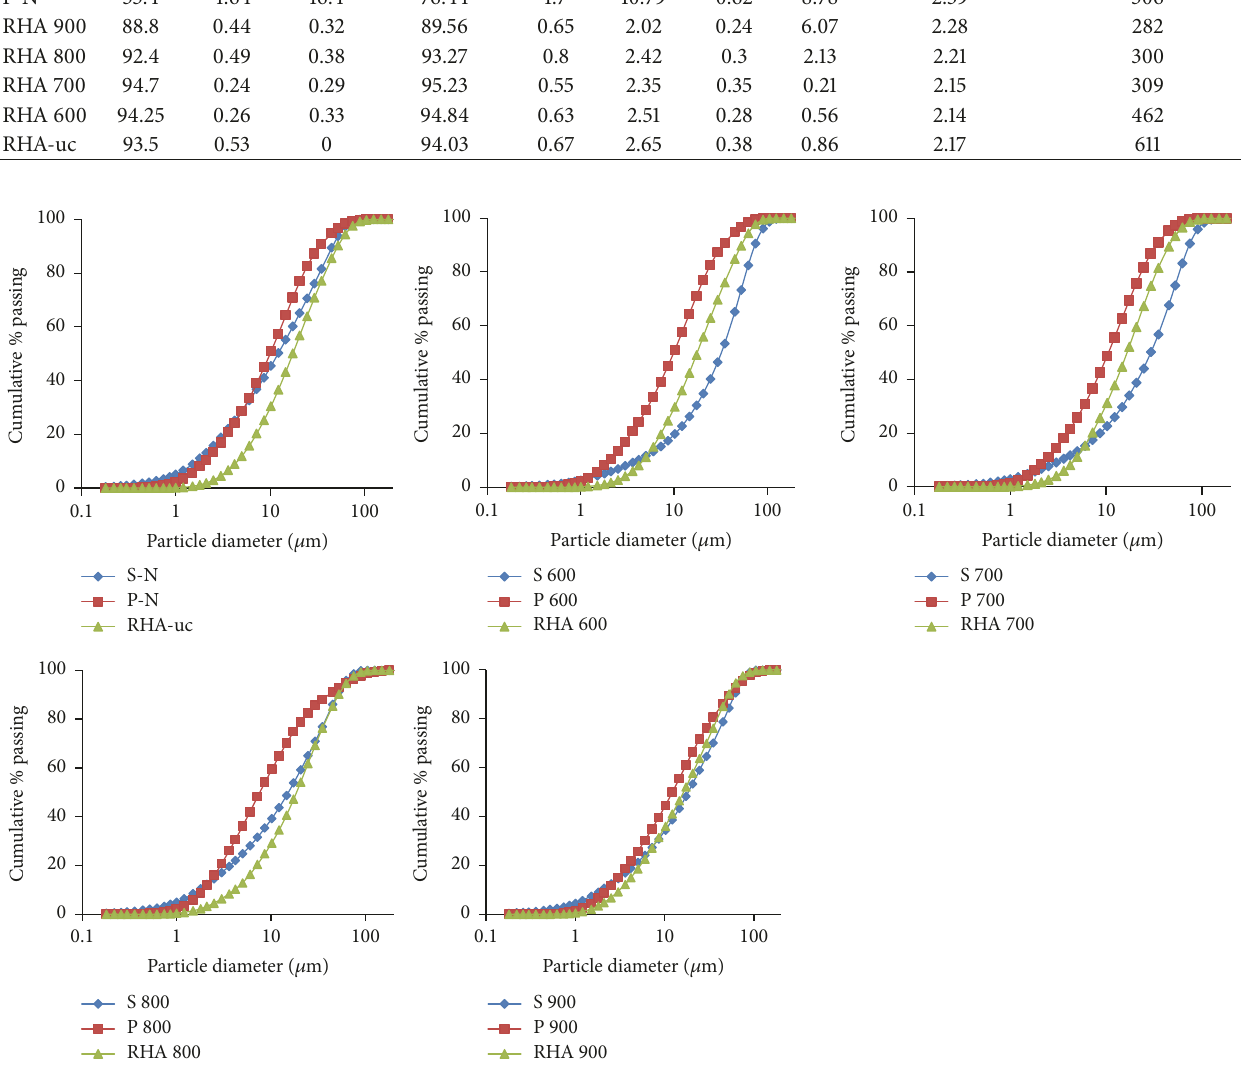
Figure 2: PSD profiles for scoria, pumice, and RHA at different calcination